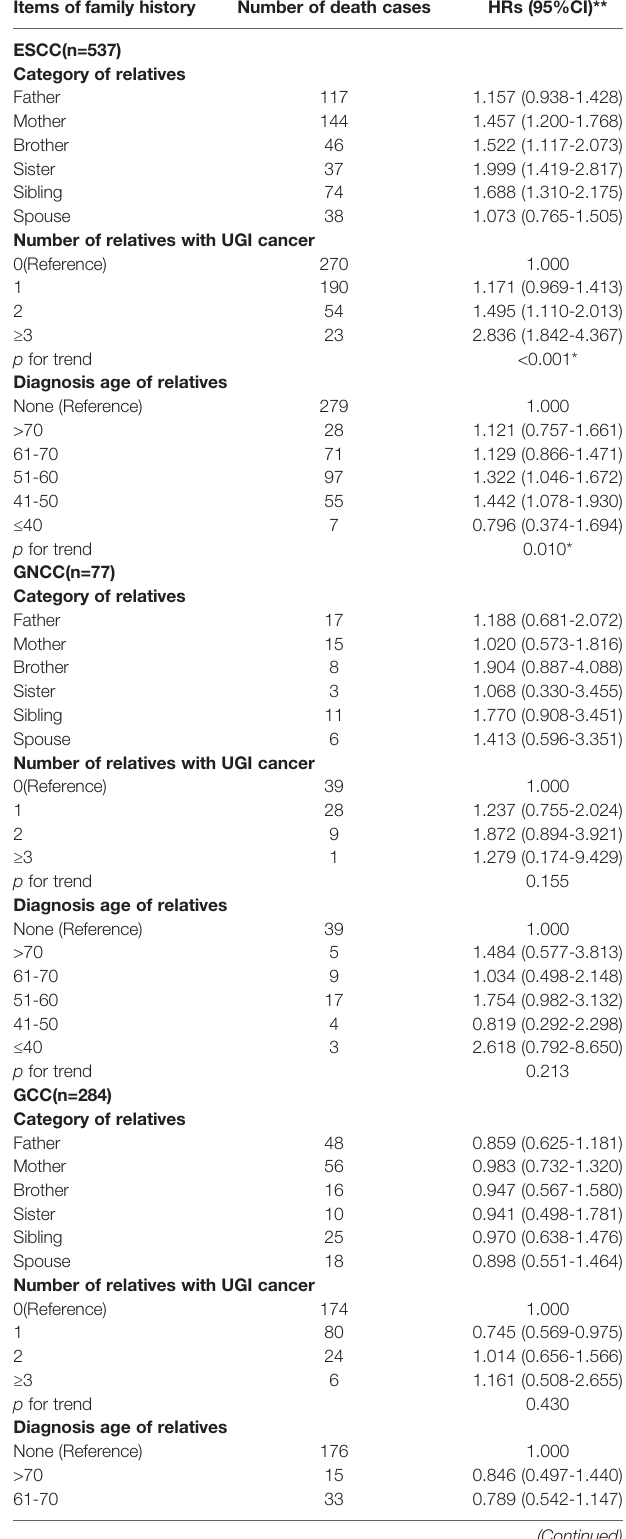
TABLE 3 | Effect of detailed items of family history on the risk of death from UGI cancer. Items of family